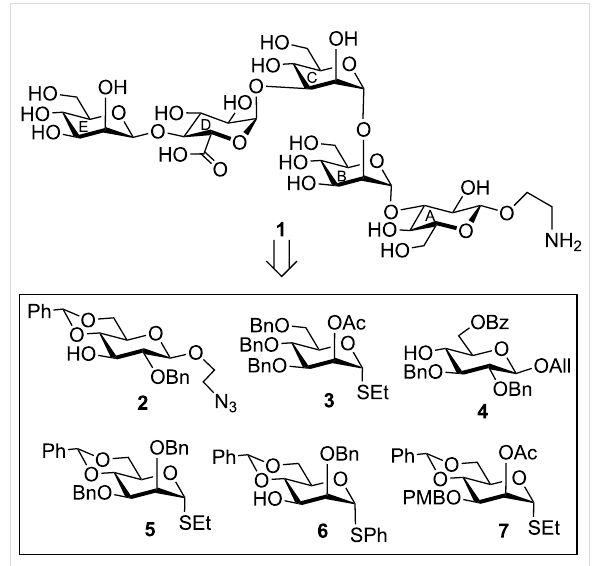
Figure 1: Structure of the synthesized pentasaccharide corresponding to the repeating unit of the biofilms produced by Klebsiella pneumo-